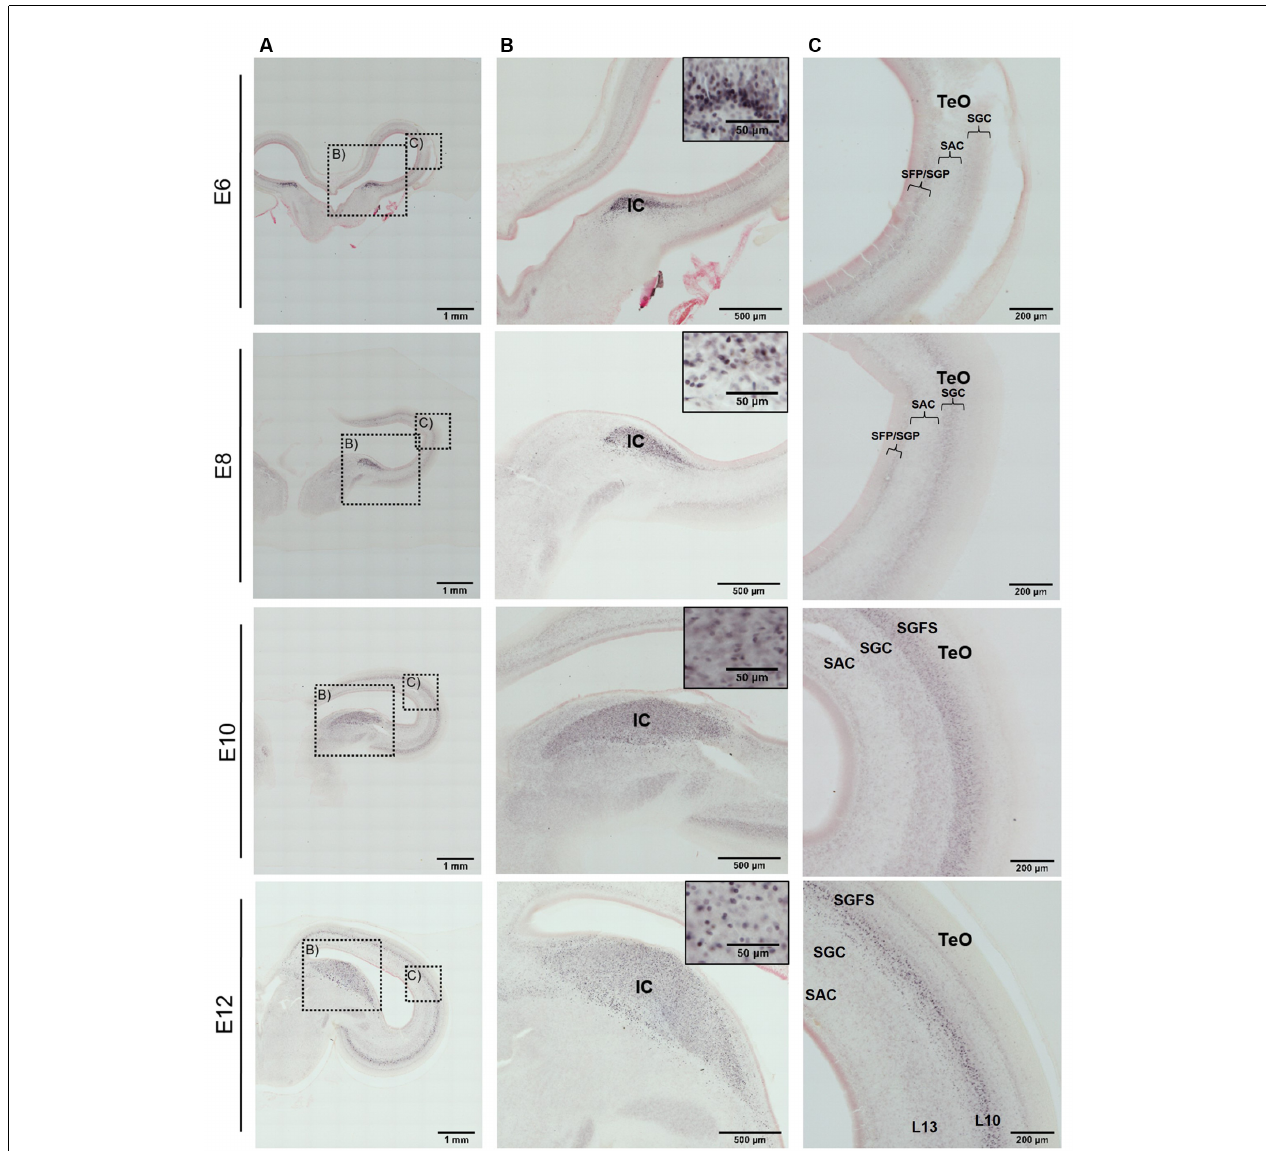
FIGURE 3 | Immunohistochemistry against AP-2 δ in chicken midbrains of E6–12 embryos. Frontal slices with DAB staining and neutral red counterstaining. (A) Overview of midbrain hemisphere, scale bar 1 mm. (B) Labeling in the inferior colliculus (IC) and cell nuclei staining (inset). Scale bars 500 µ m and 50 µ m (inset). (C) Labeling in the optic tectum (TeO). SFP, stratum fibrosum periventriculare ; SGP, stratum griseum periventriculare ; SAC, stratum album centrale ; SGC, stratum griseum centrale ; SGFS, stratum griseum et fibrosum superficiale . Scale bar 200 µ